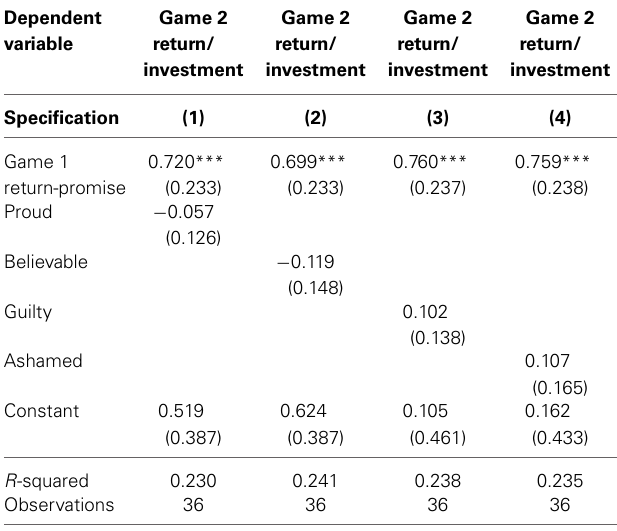
Table 10A | Regression of game 2 ROI on promise breaking trustees’